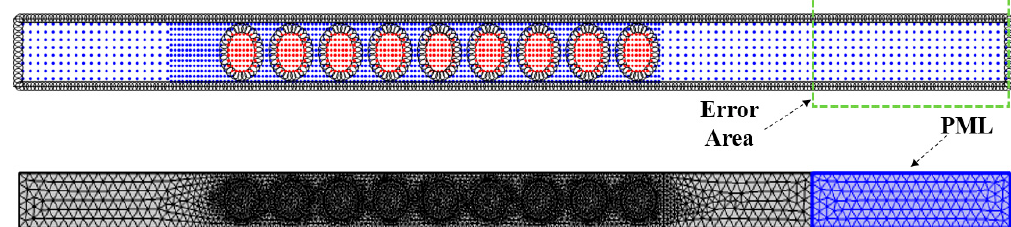
Figure 7. Node distribution with error region and element distribution with PML region for the phononic crystal with semi-infinite periodic structure in the y -direction.